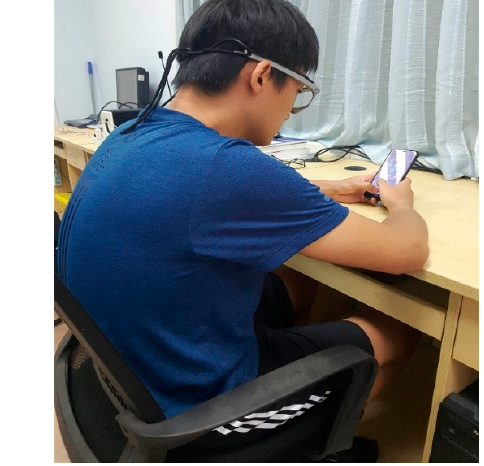
Figure 2. The experimental process.